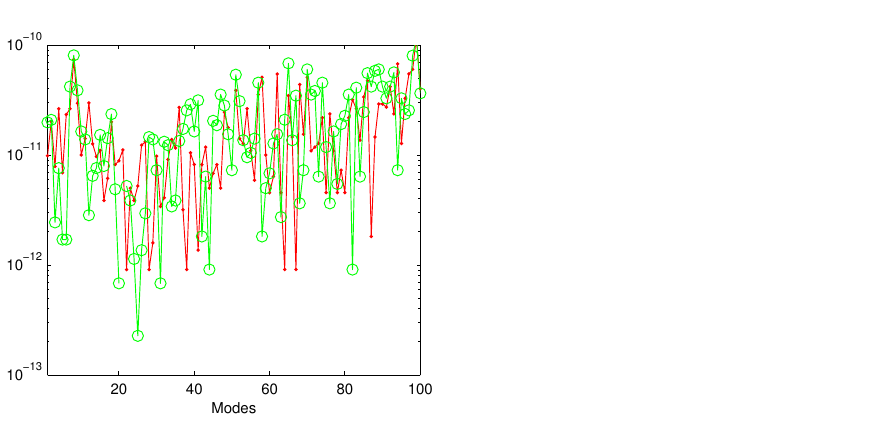
Figure 1. The drift of the first 100 eigenvalues of the Coffey-Evans problem. ChC used the orders of approximations N 1 : = 256 and N 2 : = 512-red dotted line and, respectively, N 1 : = 400 and N 2 : = 512-green circled line.